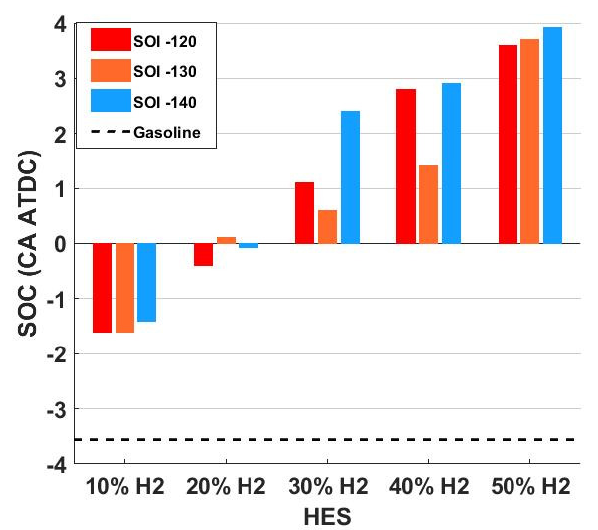
Figure 8. Start of combustion (SOC) for different case studies.